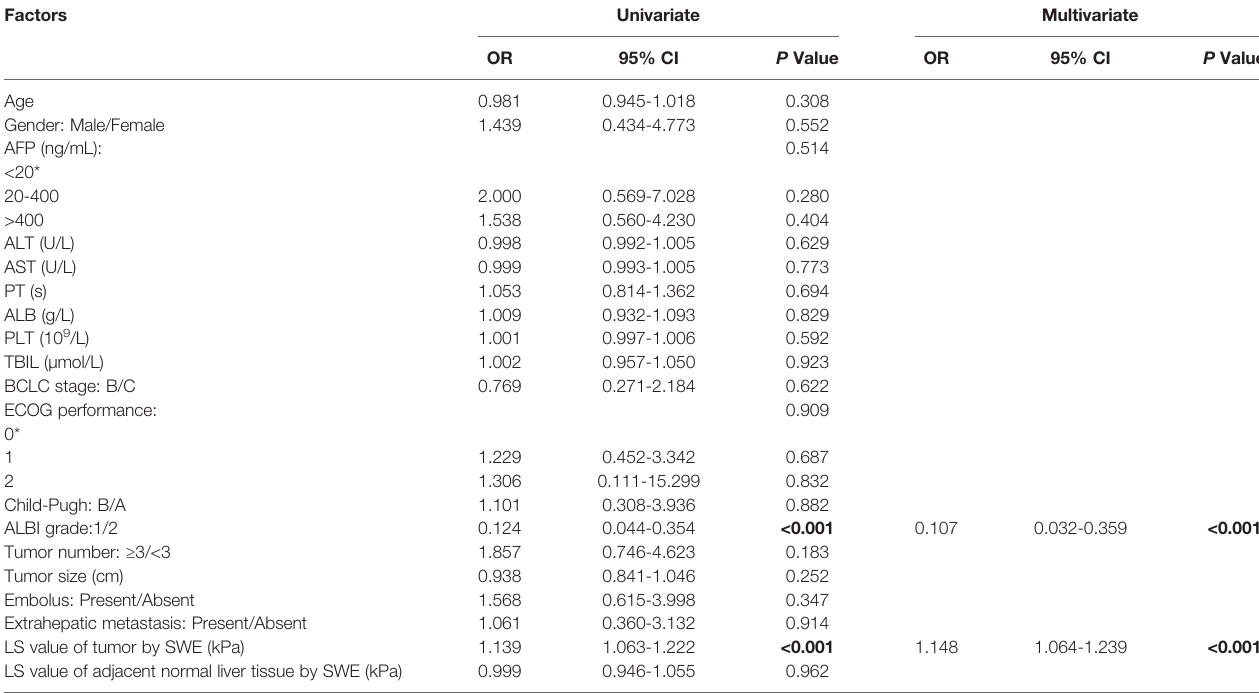
TABLE 4 | Univariate and multivariate logistic regression analyses of baseline variables predicting PD in training set (n = 93).